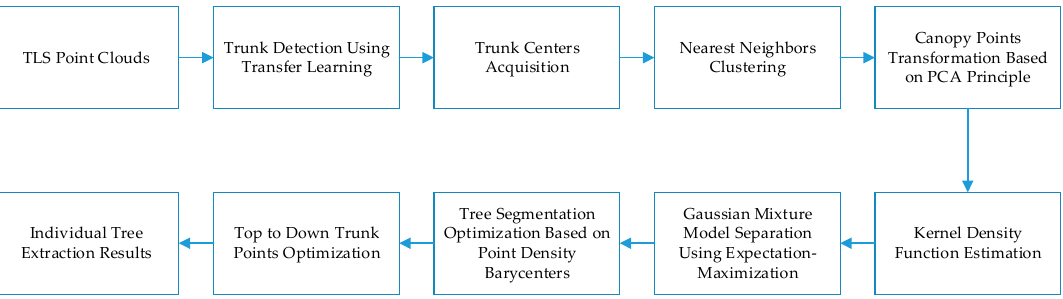
Figure 1. Flowchart of the proposed method.